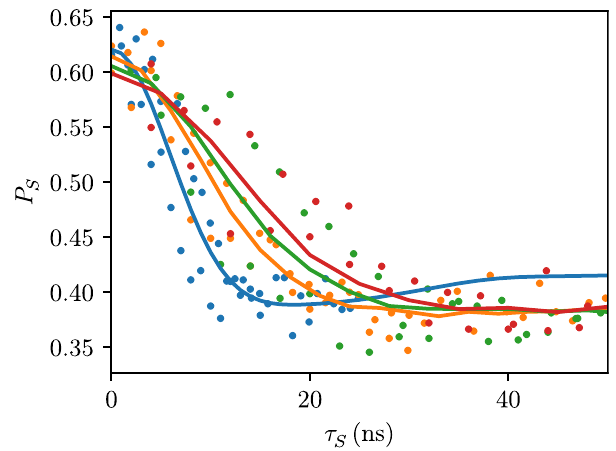
FIG. 10. The simulated decays of the quasistatic electron spin coherence, using the same data set as in Fig. 3(e). The experimen- tal data (dots) are compared with the simulations (solid lines) of the coherence spin in the quasistatic case (the remanence param- eter is irrelevant here, as each configuration is explored only a single time). The overshoot in the singlet probability described in Ref. [26] is observed in the simulations only for the double quantum dot case (blue) and is not observed in the experimental data. For the two electrons in three (orange), four (green), or five (red) dots, the simulated decays are